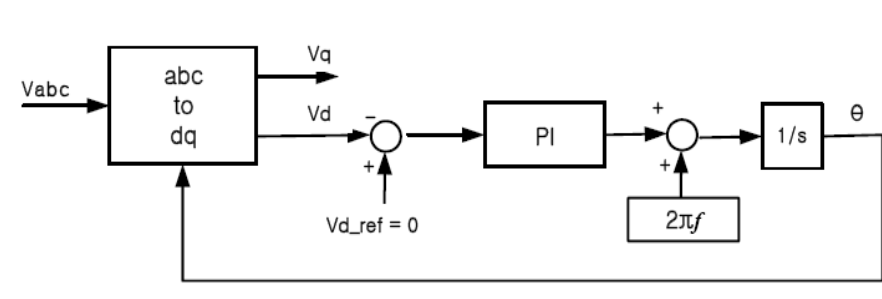
Figure 7. Block diagram of PLL.